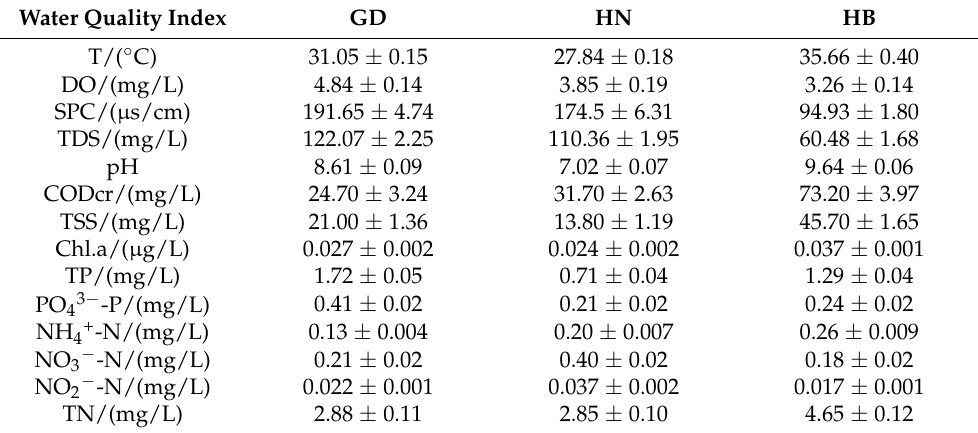
Table 1. The water quality parameters in different regions ( n = 6).